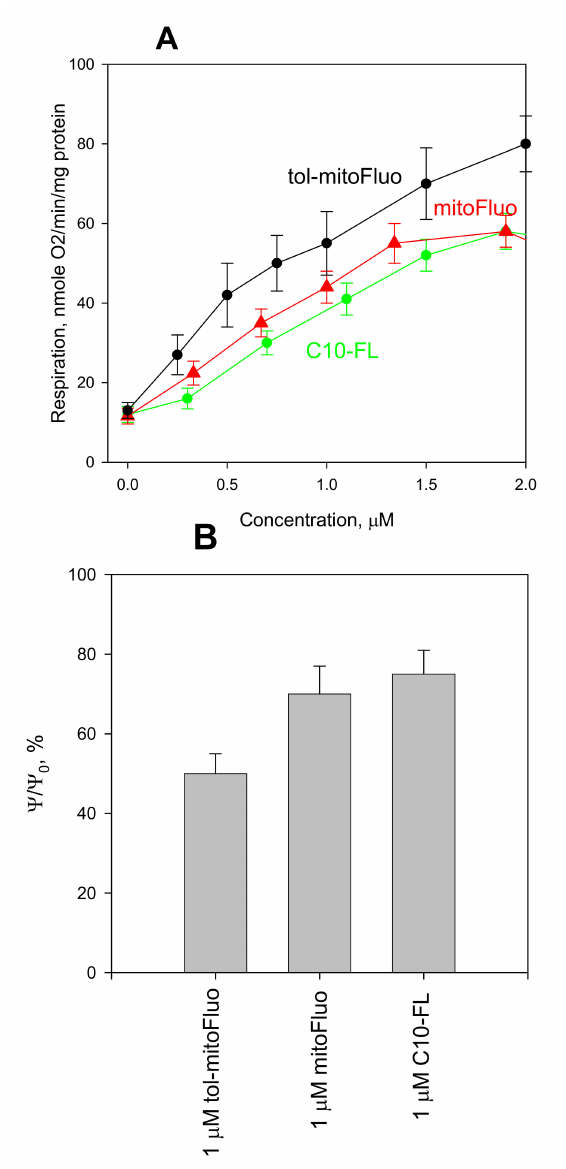
Figure 2. ( A ) The dose dependence of the stimulation of rat liver mitochondria respiration by tol-mitoFluo (black curve), mitoFluo (red curve), and C10-FL (green curve) with succinate as a substrate. ( B ) The e ff ect of tol-mitoFluo, mitoFluo, and C10-FL (concentration, 1 µ M) on the membrane potential of RLM estimated by the absorbance changes of the potential-sensitive dye safranine O (15 µ M). Measurements of the membrane potential and respiration were performed in the incubation medium (see Experimental Section ) with 5 mM succinate and 2 µ M rotenone. The data are the mean ± SD of at least three